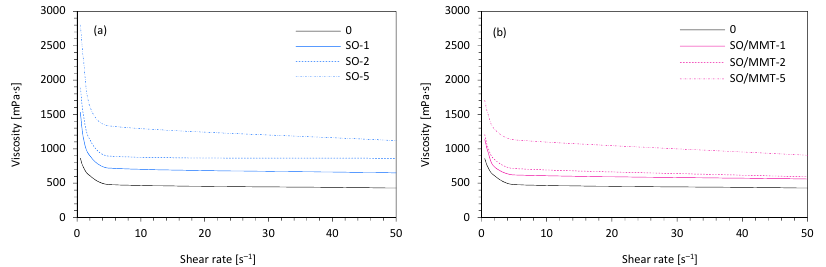
Figure 4. The viscosity of polyol systems containing ( a ) SO filler, and ( b ) MMT-modified SO filler.